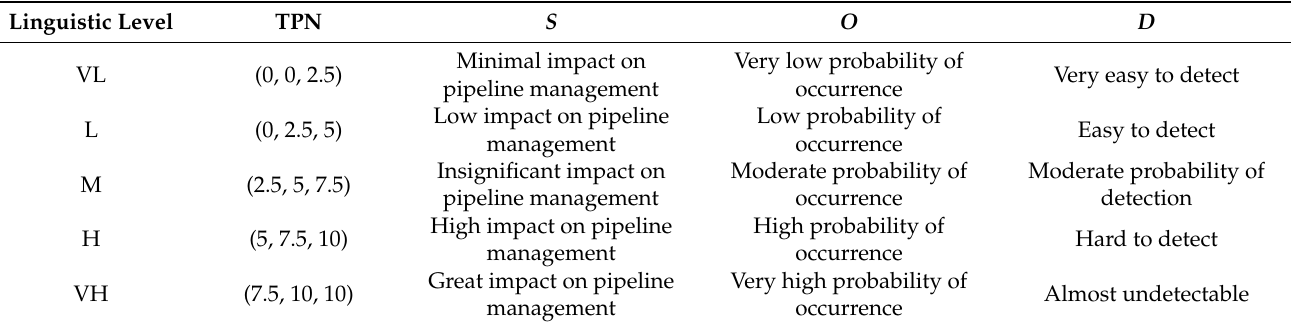
Table 2. TPN values of input